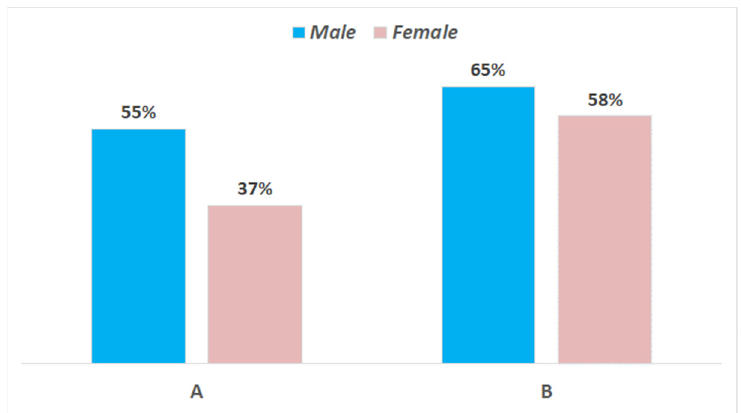
Figure 5. Results of consumer testing of the cheese samples from trials A and B at 1 day. Liking levels according to gender are reported in histograms . Percentages of positive answers (appreciated + much appreciated).